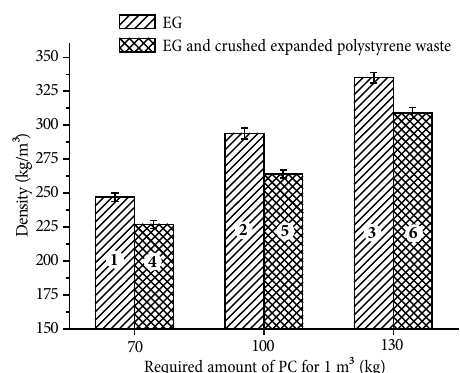
Required amount of PC for 1 m  Fig. 2. Influence of the amount of PC on density of LWAC samples of 1÷6 compositions